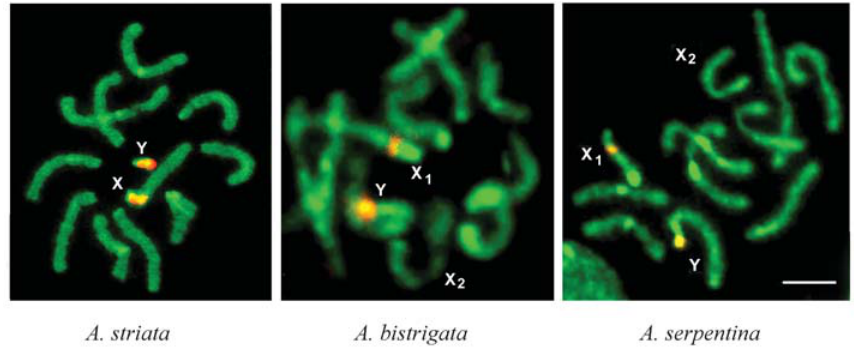
Figure 2 - Fluorescence in situ hybridization (FISH) of male mitotic chromosomes from the three Anastrepha species with the rDNA pDm238 probe. Merged images of DAPI-stained chromosomes (green) and hybridization signals (red) show that the ribosomal genes are localized in heterochromatic blocks on the sex chromosomes of the three species, one block in the Y chromosome, and one in the X of A. striata, and in the X 1 chromosomes of A. bistrigata and A. serpentina . Bar represents 10 μ